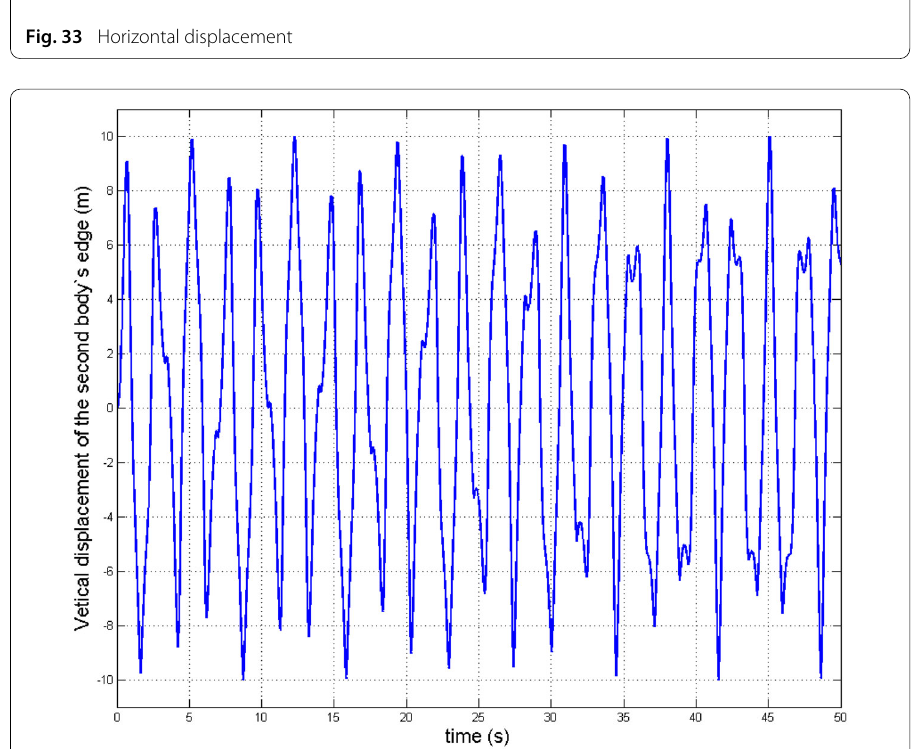
Fig. 34 Vertical